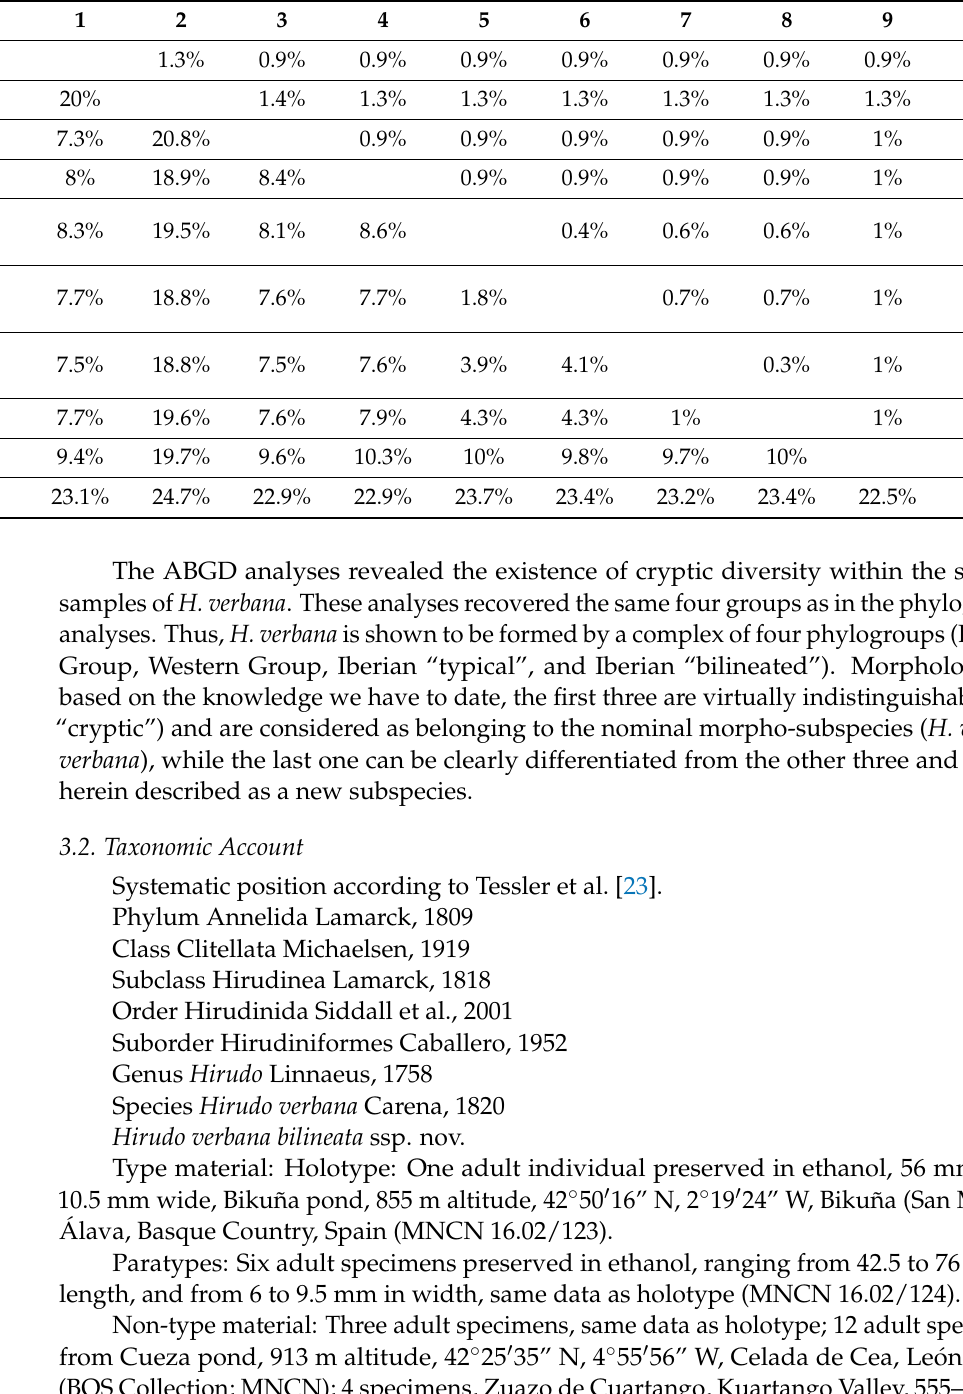
Table 2. The p-distances calculated between groups of Hirudo based on haplotypes of concatenated COI and 12S sequences. Standard error estimate(s) are shown above the